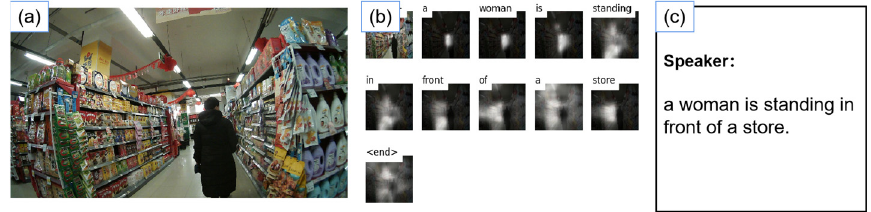
Figure 18. Image processing results of a store scene. ( a ) Processed images. ( b ) Processed results. ( c ) Report contents.